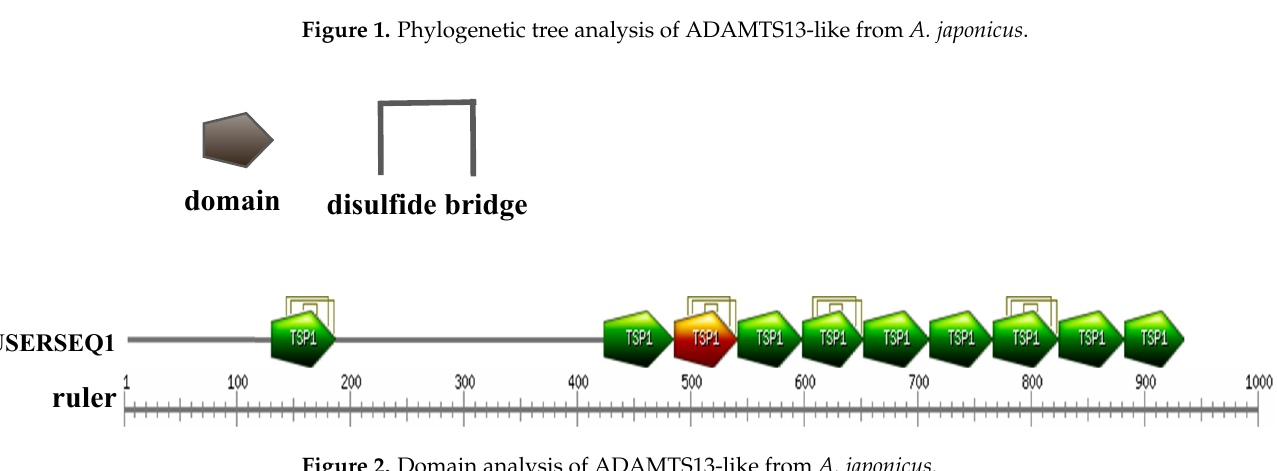
Figure 1. Phylogenetic tree analysis of ADAMTS13-like from A. japonicus .